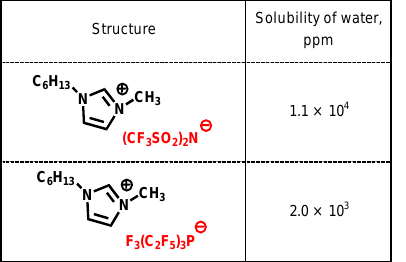
Courtesy of Merck